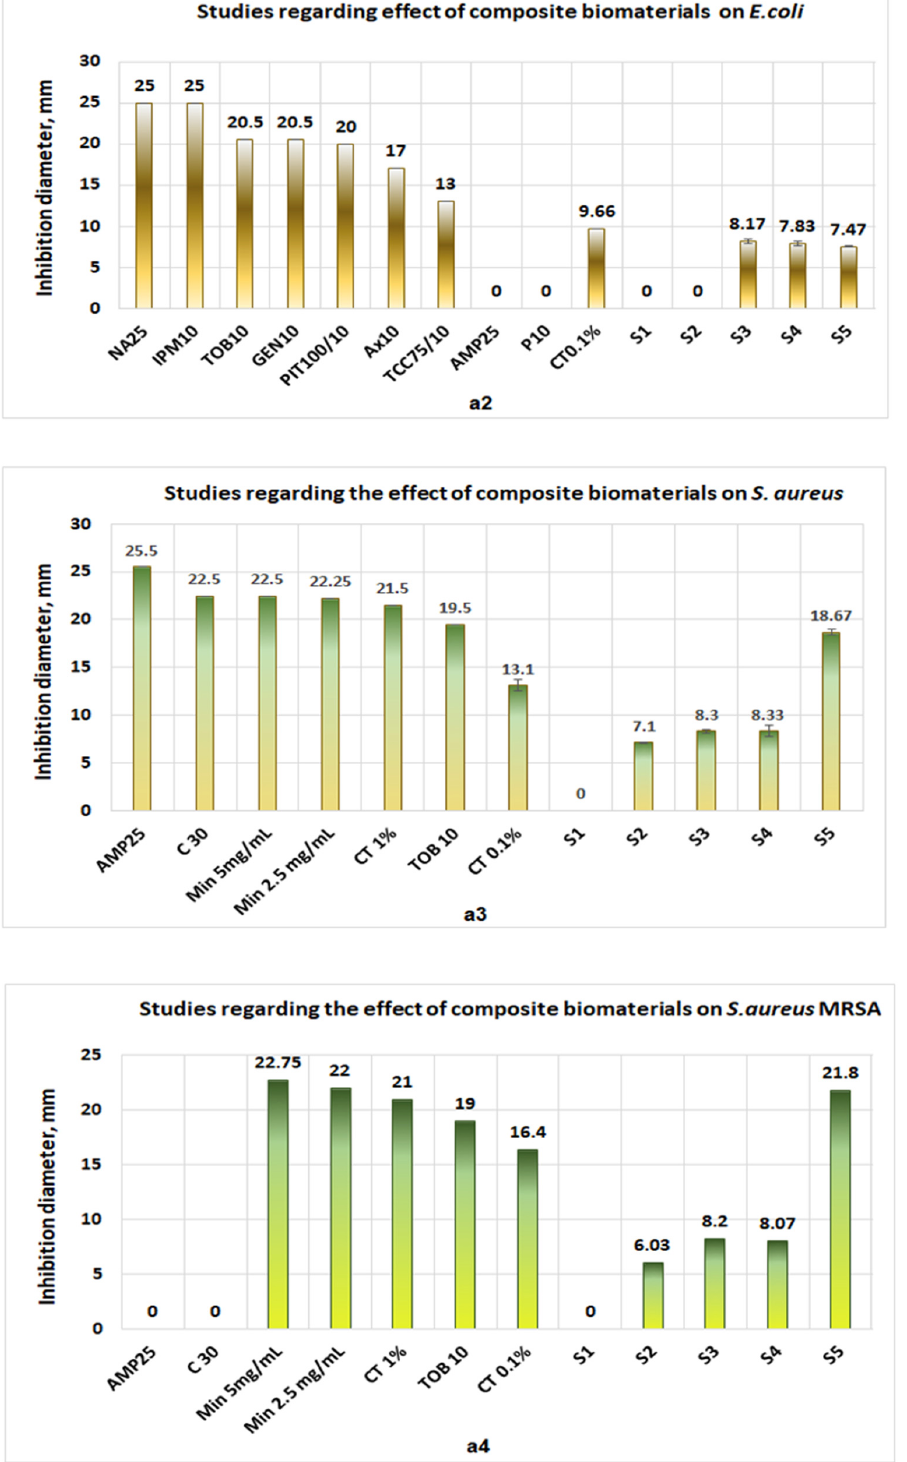
Figure 11. Studies regarding antimicrobial activities of biomaterials of the types S1 (collagen sponge), S2 (chitosan sponge), S3 (composite biomaterial obtained from collagen–chitosan at mass ratio 1:1), S4 (sponge obtained from collagen–chitosan mass ratio 3:1), and S5 (composite biomaterial obtained from collagen–chitosan–clotrimazole mass ratio = 1:1:0.1). ( a1 ) antimicrobial activities on Candida albicans ; ( a2 ) antimicrobial activities on Escherichia coli ; ( a3 ) antimicrobial activities on Staphylococcus aureus ; ( a4 ) activities on Staphylococcus aureus MRSA.